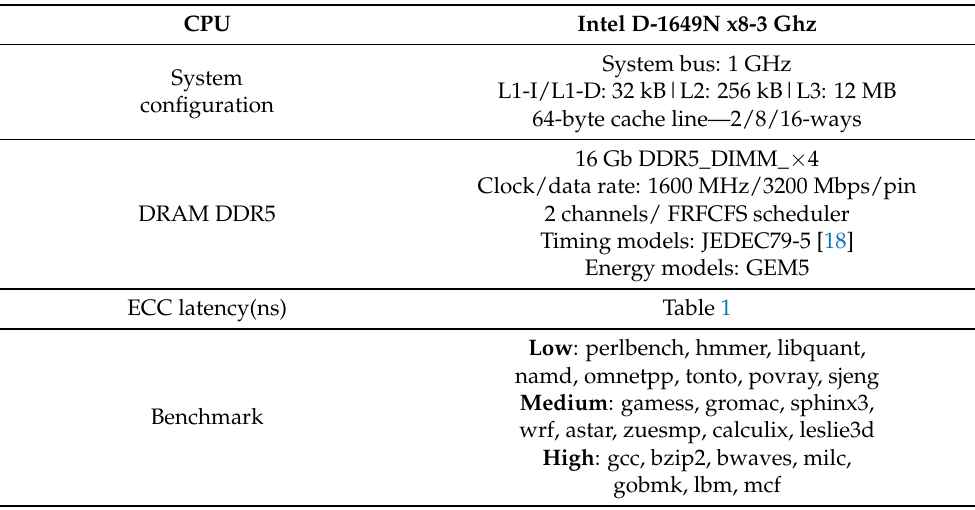
Table 3. Evaluation configuration of OBET-based schemes and the state-of-the-art works.